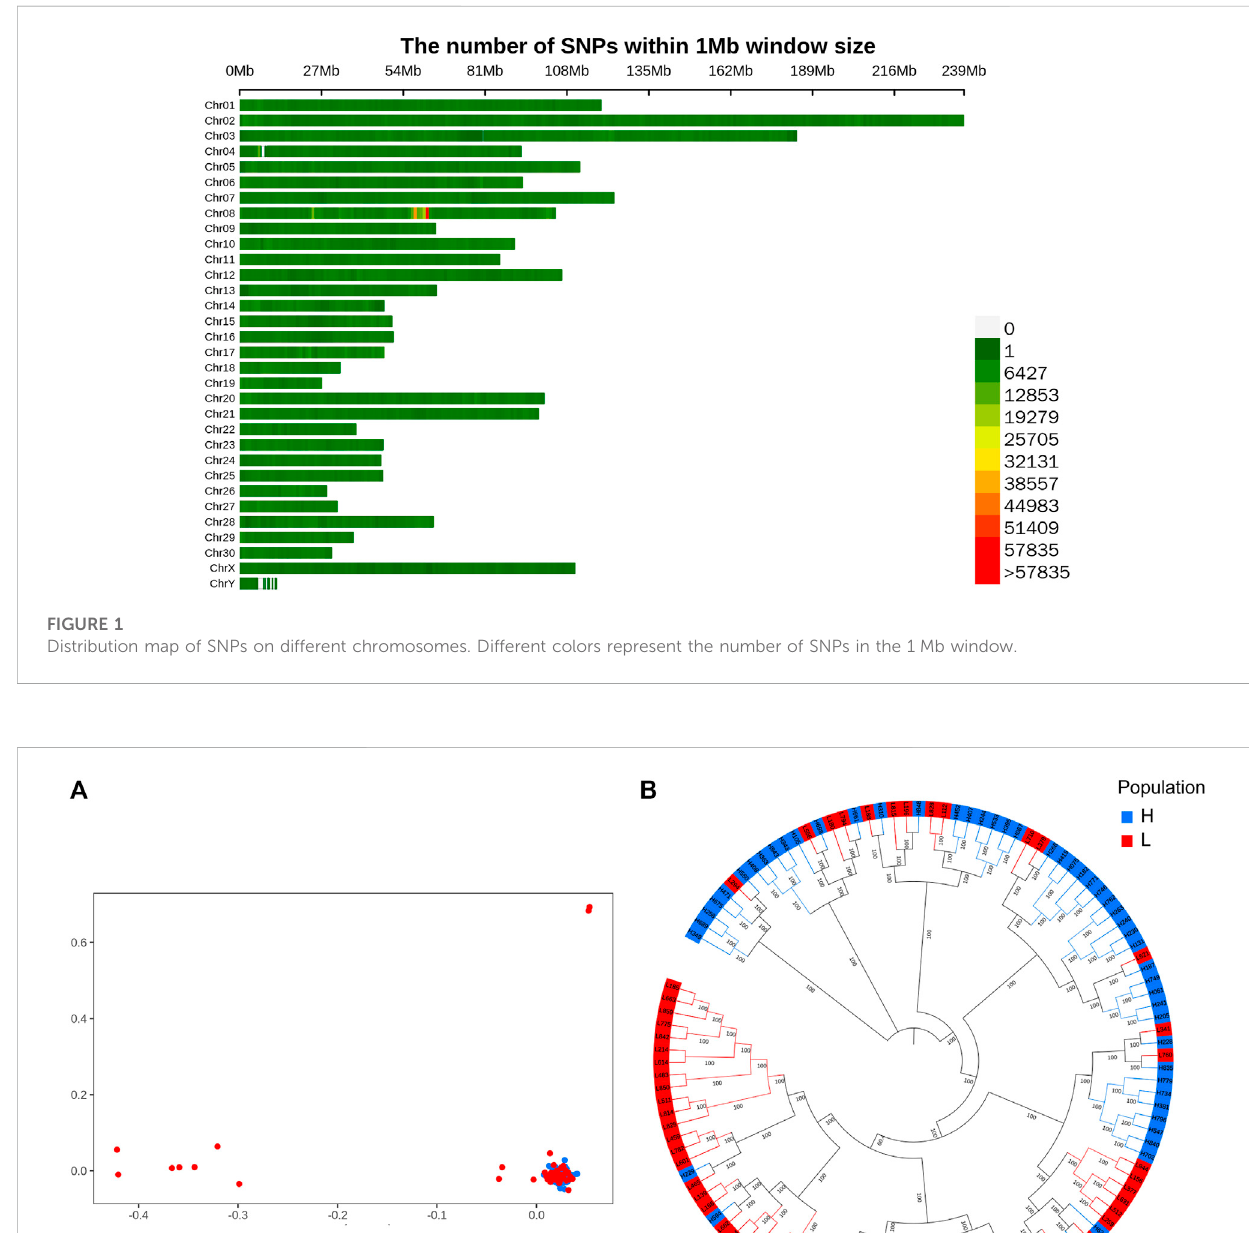
99.79% (Supplementary S3), implying that the mapping rate could be used for subsequent variant detection. S4). Their distribution on the